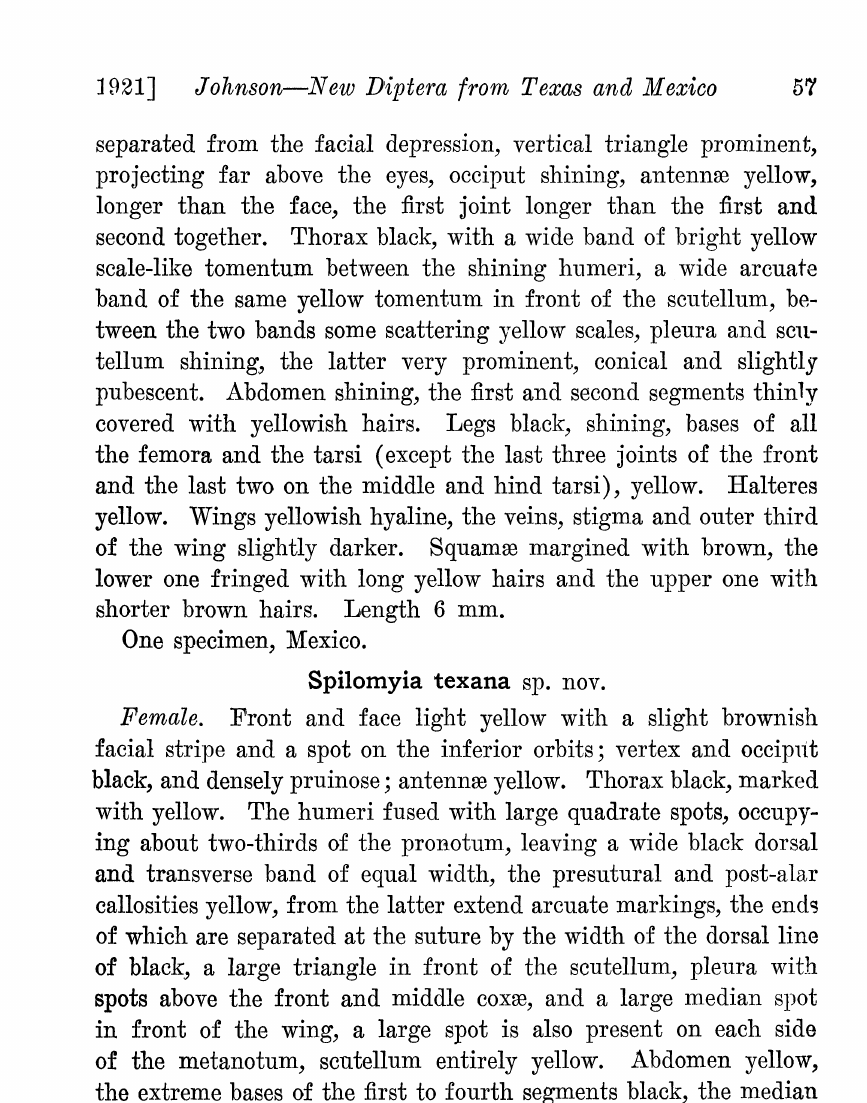
Legs black, shining, bases o all the femora and the tarsi (except the last three joints o the ront and the last two on the middle and hind tarsi), yellow, ttalteres yellow. Wings yellowish hyaline, the veins, stigma and outer third of the wing slightly darker. Squamm margined with brown, the lower one fringed with long yellow hairs and the upper one with shorter brown hairs. Length 6 ram. One specimen, Mexico. Spilomyia texana sp. nov. Female. Front and face light yellow with a slight brownish aciat stripe and a spo on the inerior orbits; vertex and occiplit black, and densely pruinose; antennm yellow. Thorax black, marked with yellow. The humeri lused with large quadrate spots, occupy- ing about two-thirds of the pronotum, leaving a wide black dorsal and transverse band of equal width, the presutural and post-alar callosities yellow, from the latter extend arcuate markings, the end o_ which are separated at the suture by the width of the dorsal line o black, a large riangle in front of the scutellum, pleura with spots above the ront and middle coxm, and a large median spot o the wing, a large spot is also present on each side in _ront of the metanotum, scutellum entirely yellow. Abdomen yellow, the extreme bases o the first to ourth segments black, the median interrupted bands on the second to ourth segments and occupying slightly oblique depressions, are brown, not black. Ventral seg- ments brownish black, margined with yellow. Legs, including the coxe, yellow, except the outer hal o the ront tibim and all the front tarsi, which are black. Italteres yellow. Anterior of the ar wing, as as the ourth vein, clouded with brown, fifth vein widely margined with brown. Length 18